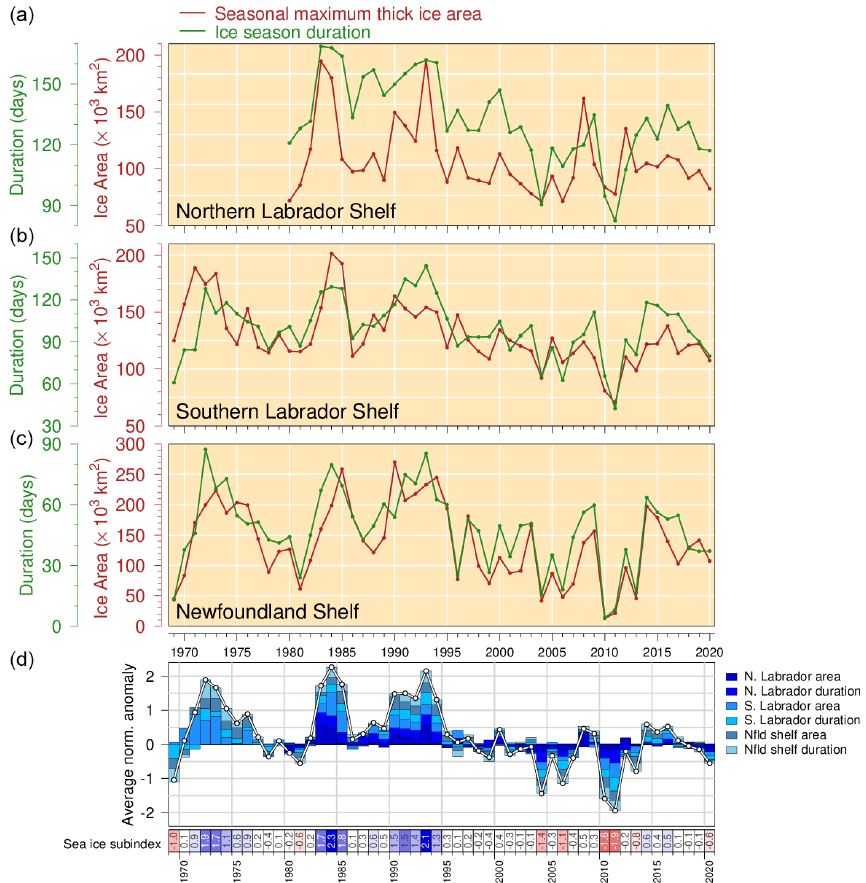
Figure 4. Sea ice season duration (green) and seasonal maximum area covered by thick ice (red) for the northern and southern Labrador shelves (a, b) and Newfoundland shelf (c) . The northern Labrador time series starts in 1980, while the two others start in 1969. The six time series are transformed into normalized anomalies and presented in a stacked bar fashion in panel (d) . The scorecard at the bottom of this last panel presents the numerical values of the mean normalized anomalies for each year. Here negative anomalies (indicative of warmer conditions) are coloured red and positive anomalies (colder conditions) blue. This time series is one component of the NL climate